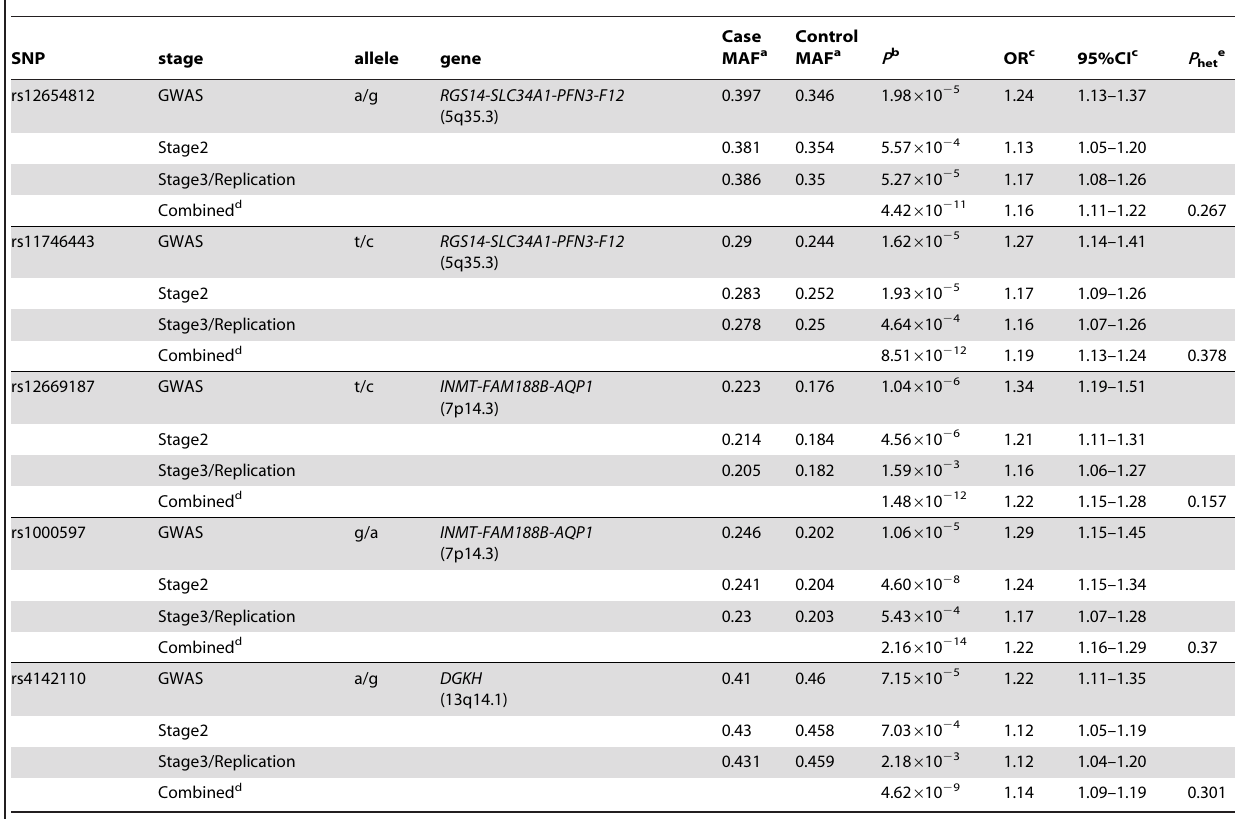
Table 1. Summary of GWAS and replication